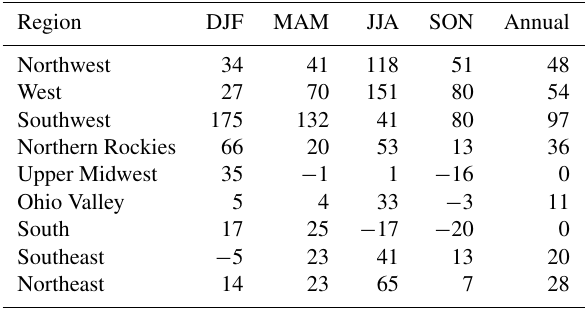
Table 1. Seasonally and regionally averaged biases in accumulated precipitation (%) in comparison to NARR for